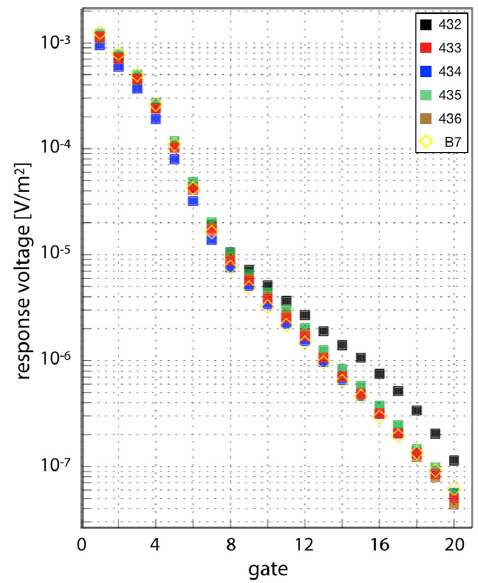
Figure 7. Decay curves of some measured G ‐ TEM soundings at the western section of study area. An unusual decay at station 432 denoted as black squares may be due to a localized highly- conductive body.